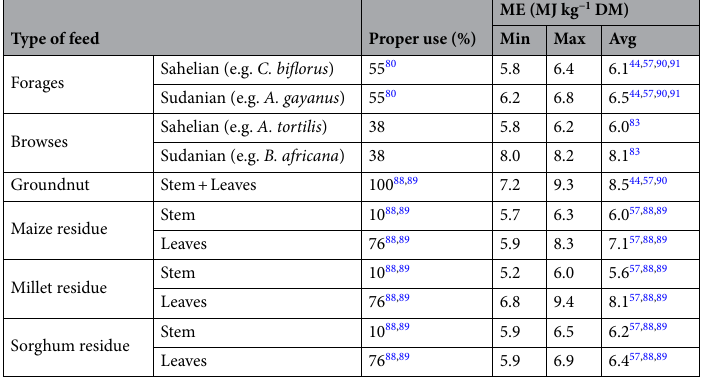
Table 1. Type of Feed resources used in the current investigation together with their proper use (the maximum proportion of feed resource that can be used to keep the sustainability of the ecosystem) and total ME (MJ ME kg −1